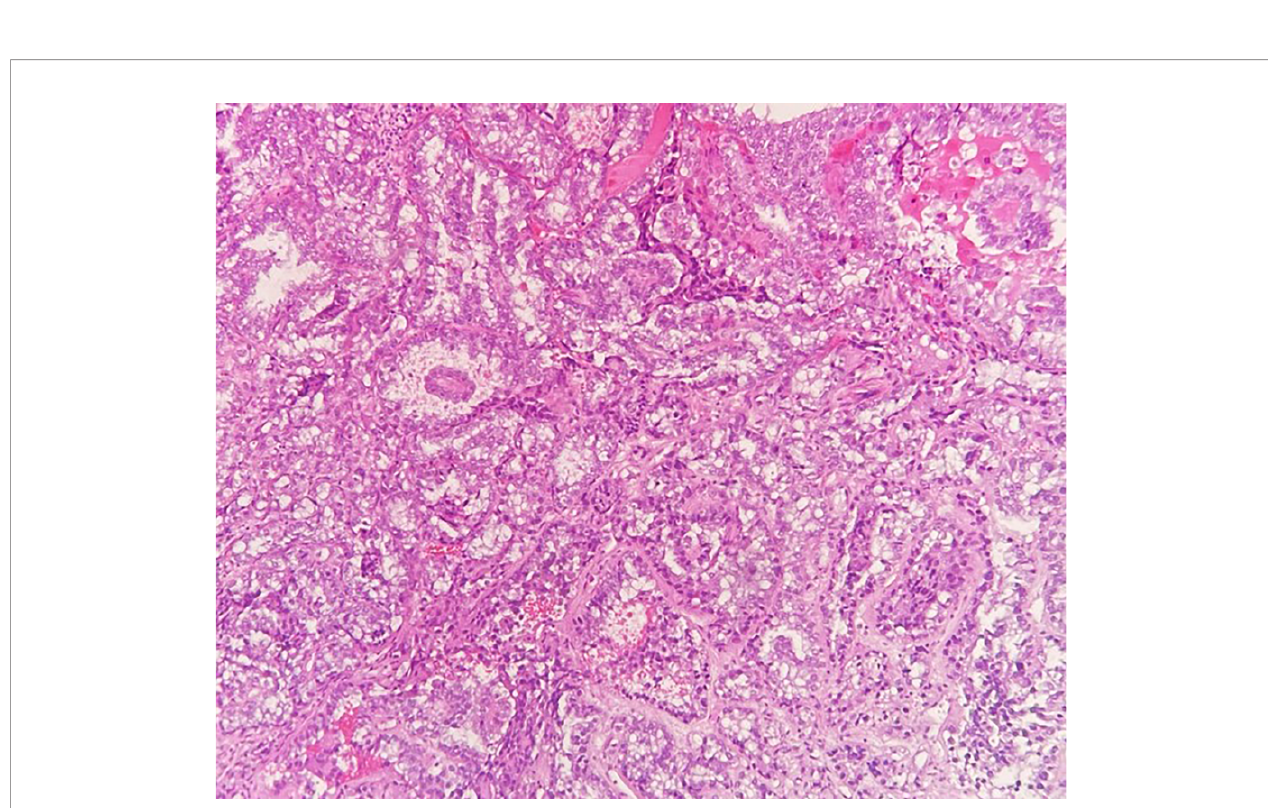
FIGURE 2 | Hematoxilyn and eosin stained clear cell adenocarcinoma biopsy.